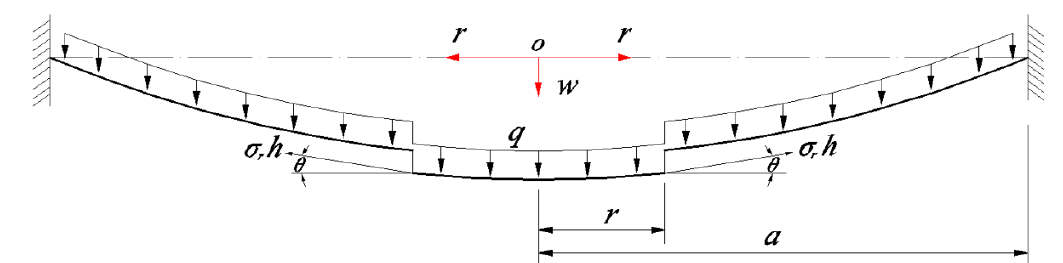
Figure 2. Sketch of the static equilibrium of the central portion ( r ≤ a ).